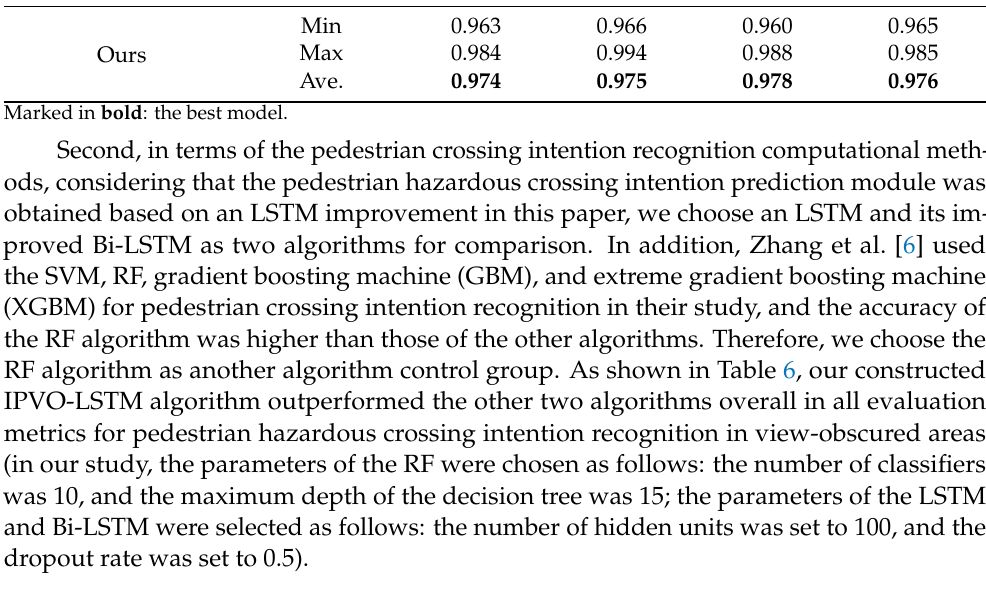
Table 6. Comparison of results for various pedestrian hazardous crossing intention recognition algorithms. Recognition Accuracy (Acc.), Recall (Rec.), F1-score (F1.), Precision (Pre.). Min, Max, and Average (Ave.) results. Model Acc. Rec. F1.